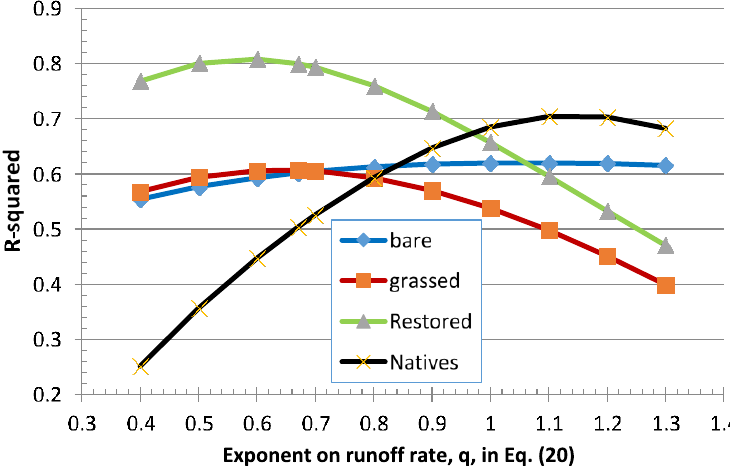
Figure 10. Dependence of linear regression R 2 values on exponent of runoff rate in stream power function when related to soil detachment rates from volcanic RS plots.